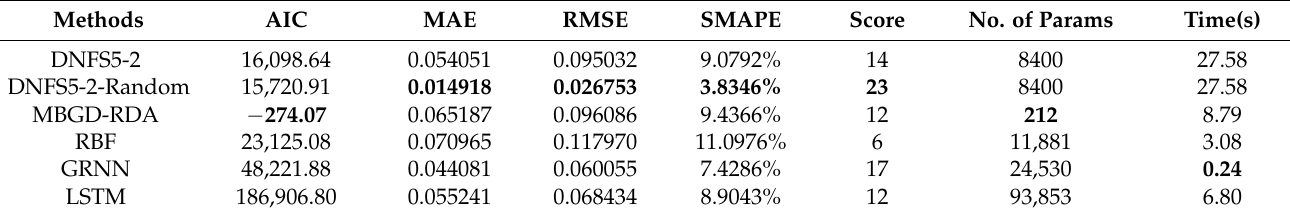
Table 12. The performance of different algorithms on Test Dataset No.